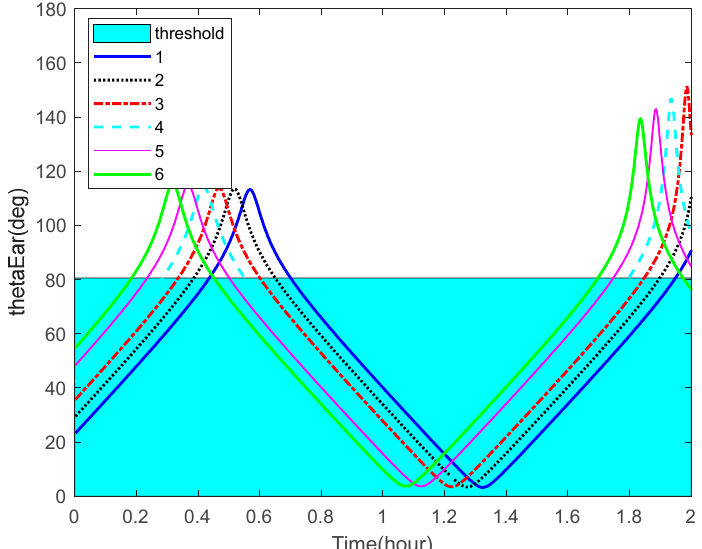
Figure 10. Earth-aircraft-target angles and the corresponding bounds.